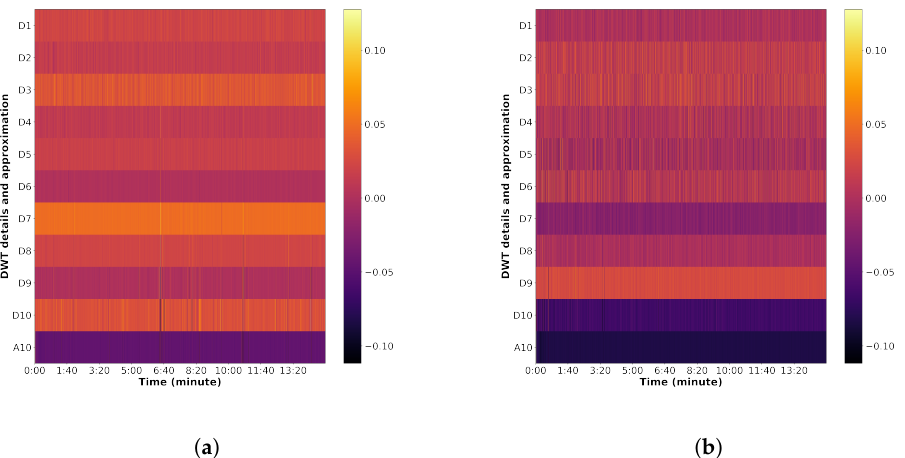
Figure 15. DWT component comparisons ( a ) without and ( b ) with heavy rainfalls.